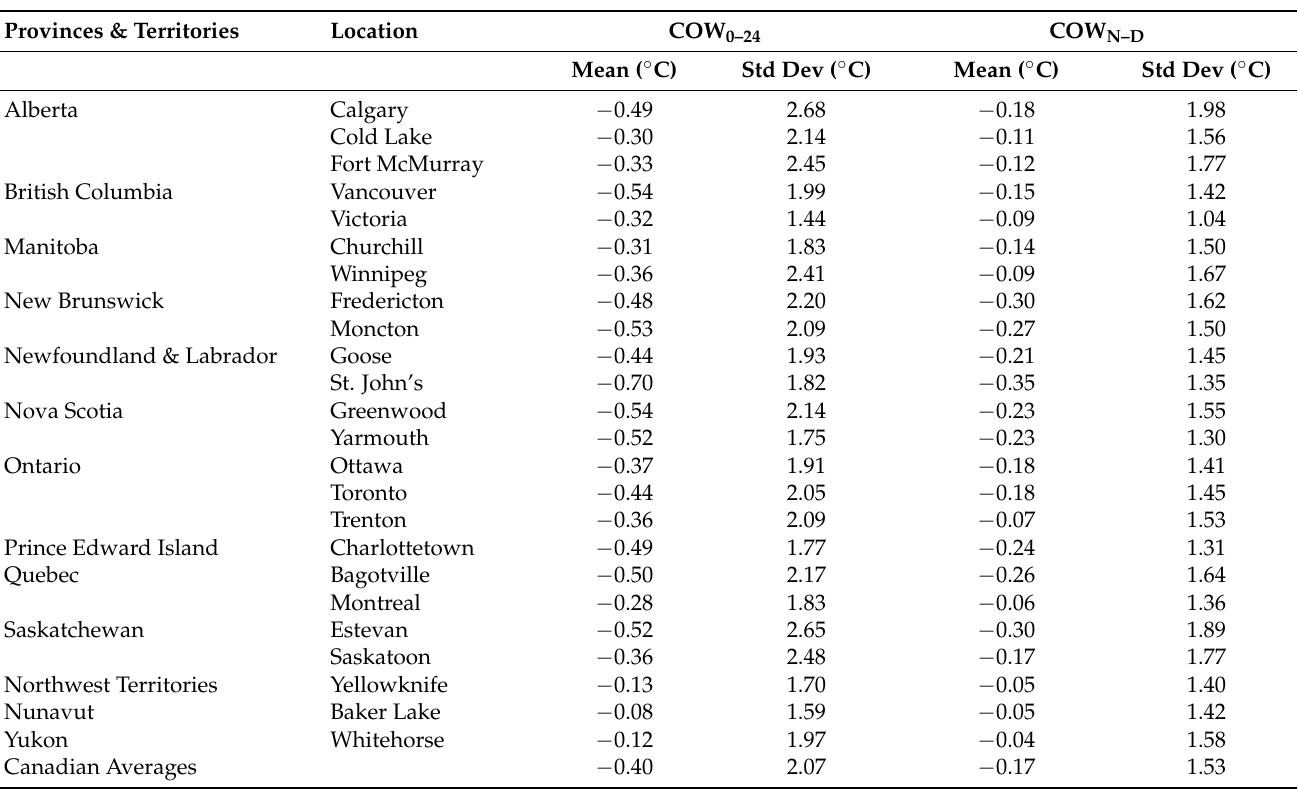
Table 2. The mean and standard deviation of COW 0–24 and COW N–D error distributions presented in Figure 6 and Appendix